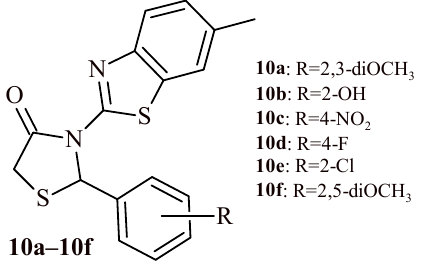
Figure 4. The oxazinyl-thiazolidin-4-ones ( 9a – 9f ) with antioxidant activity. Shetty et al. synthesized thiazolidin-4-one-benzothiazole hybrids ( 10a – 10f ) and con- ducted their evaluation for antioxidant activity (Figure 5) [23]. For evaluation of antioxidant activity three different models (DPPH, nitric oxide and superoxide anion radical scavenging assays) were used. The most effective compound was Derivative 10d with IC 50 values of 30.9 µg/mL (DPPH), 33.82 µg/mL (NO) and 31.88 µg/mL (Superoxide anion). However, these concentrations were higher than those for ascorbic acid used as standard (IC 50 values in the range of 24.99–25.73 µg/mL).